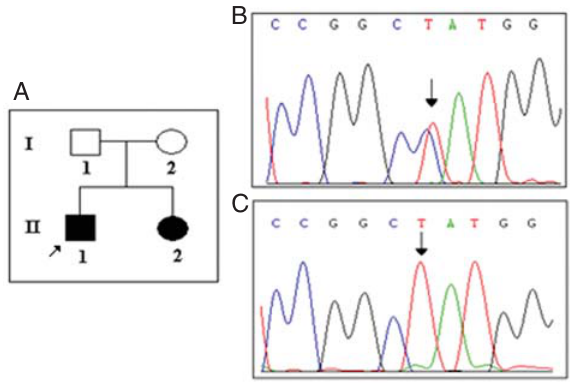
Figure 1. Novel mutation in the GJB2 gene. A, Pedigree of the family carrying the p.L76P (c.227C>T) mutation. The father (I-1) carries p.L76P in heterozygosis and the mother (I-2) carries c.35delG in heterozygosis. The sibs (II-1 and II-2) both carry p.L76P and c.35delG mutations. Sequence showing nucleotides corresponding to positions 222-231 of the GJB2 gene in the heterozygous father (B) and wild-type sequence